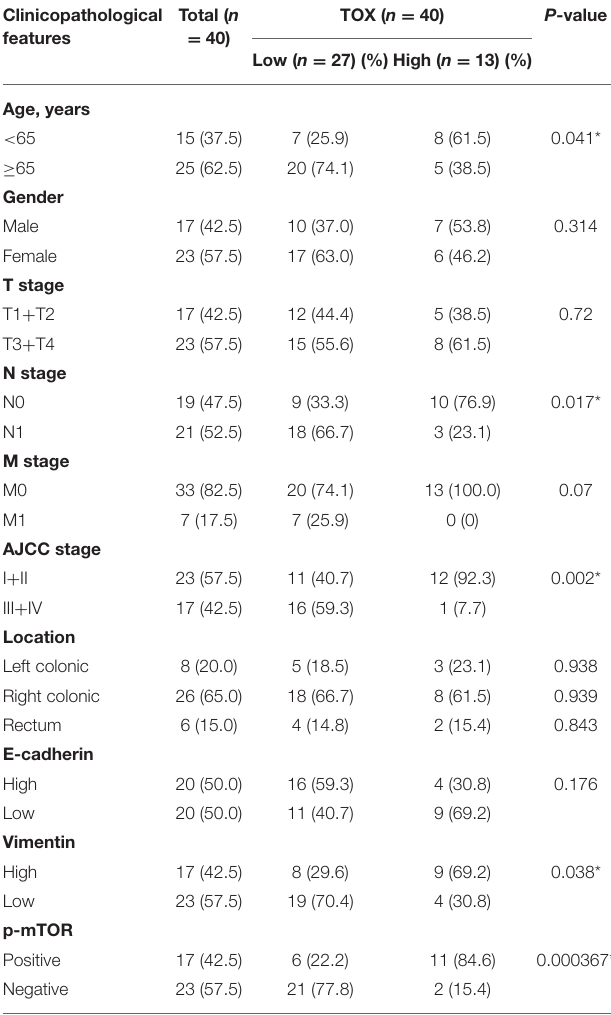
TABLE 1 | The expression of TOX in CRC and para-CRC tissues was analyzed by chi-square test. Tissue sample